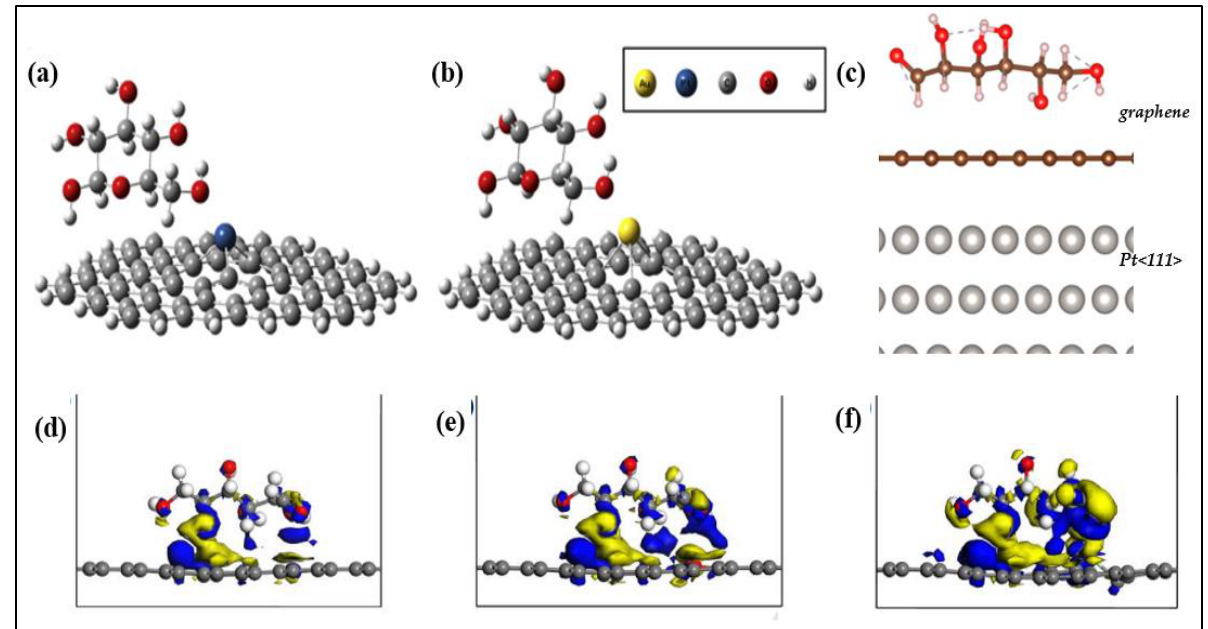
Figure 13. Optimised geometries and DOS of ( a , b ) 2 × 2 × 1 C 2 N monolayer ( c , d ) Glucose adsorbed C 2 N. Reprinted from Ref. [195].